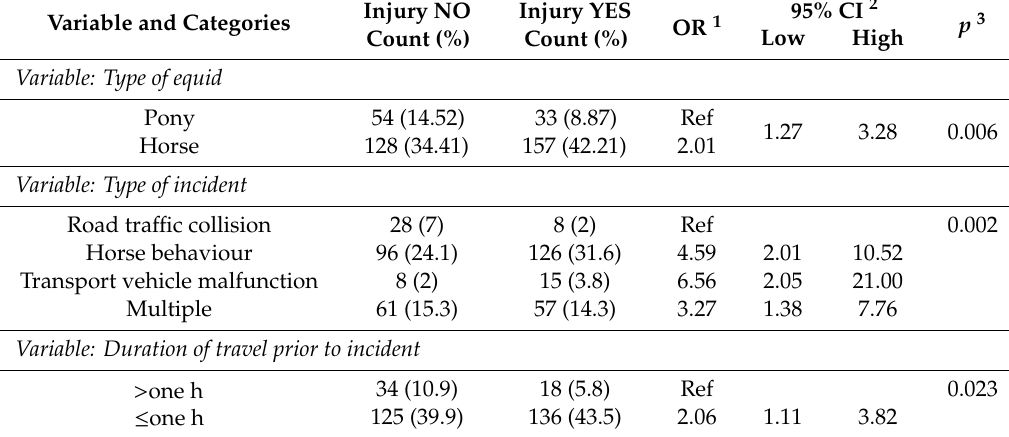
Table 10. Results of the univariate logistic regression analyses of associations between incident characteristics (significant explanatory variables: type of equid, duration of journey at the time of the incident and the type of incident) and whether the incident resulted in equine injury.